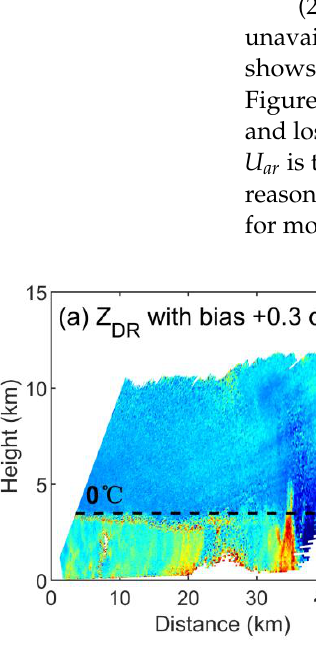
Figure 18. Sample of the impact on the U ar calculation without data quality control and attenuation correction for Z DR in the X-band. ( a ) Z DR without QC, ( b ) U ar .